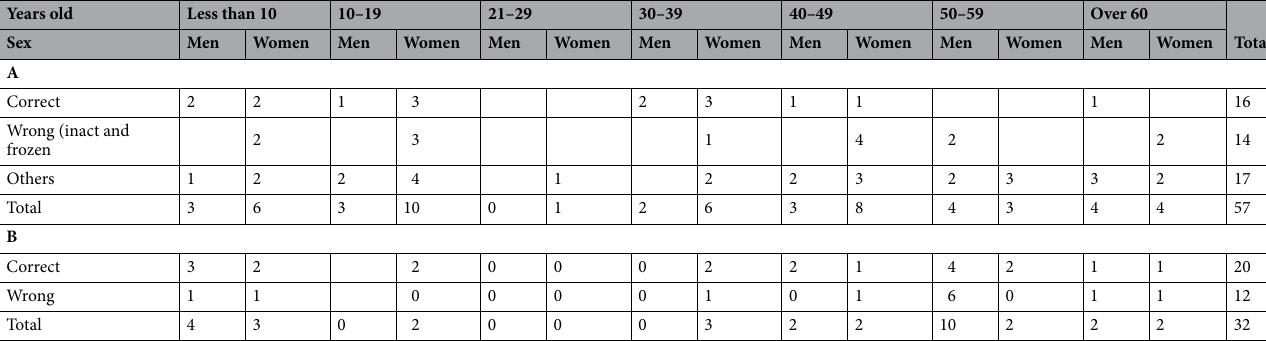
Table 2. Results of drink detection. Each answer is shown based on age and sex. A shows the results of three types of juice judgments, and B shows the results of two types of juice